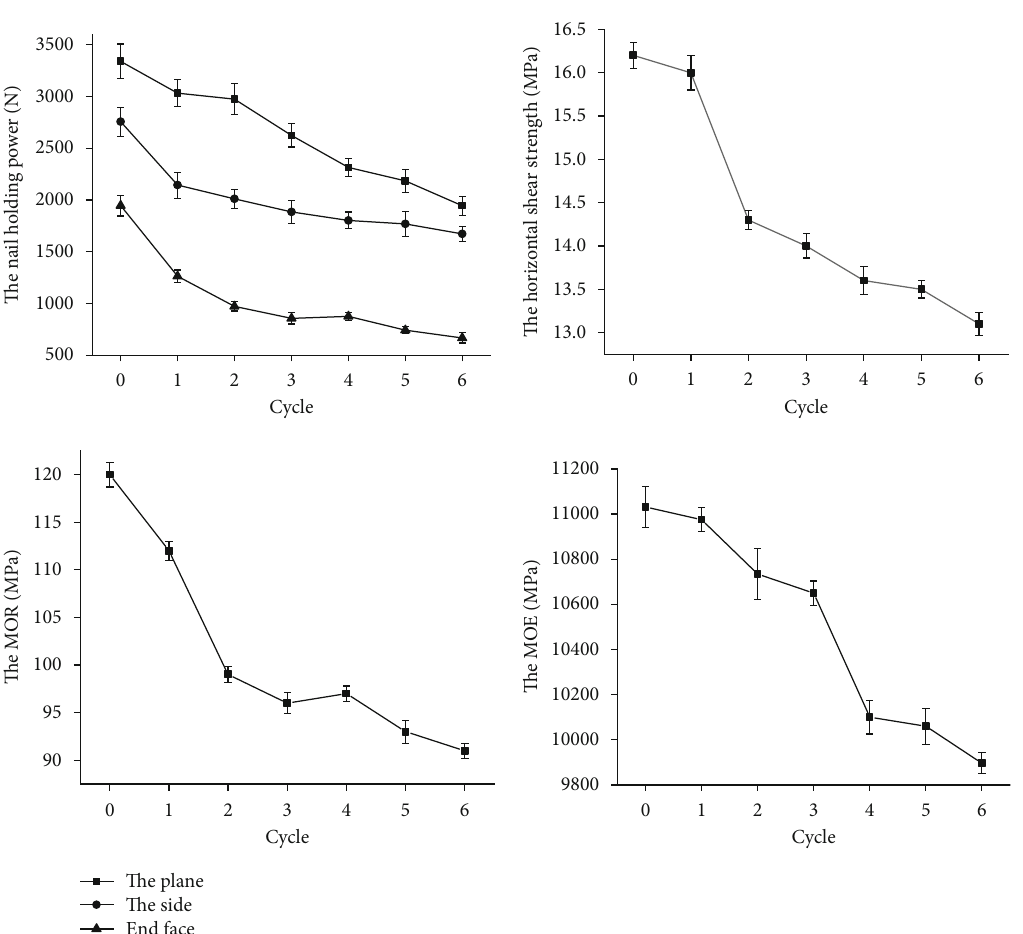
Figure 4: Results of the mechanical properties of bamboo scrimber after the six-cycle accelerated ageing treatment. Table 2: Results of the bamboo scrimber ’ s mechanical properties after the 6 h boiling-freezing-drying treatment ( mean ± standard deviation ). Nail-holding power (N) Specimens Horizontal shear strength (MPa) MOR (MPa) MOE (MPa) Plane Side End face Untreated 3339 ± 83 2756 ± 70 1945 ± 49 16 : 2 ± 0 : 05 Treated 3202 ± 80